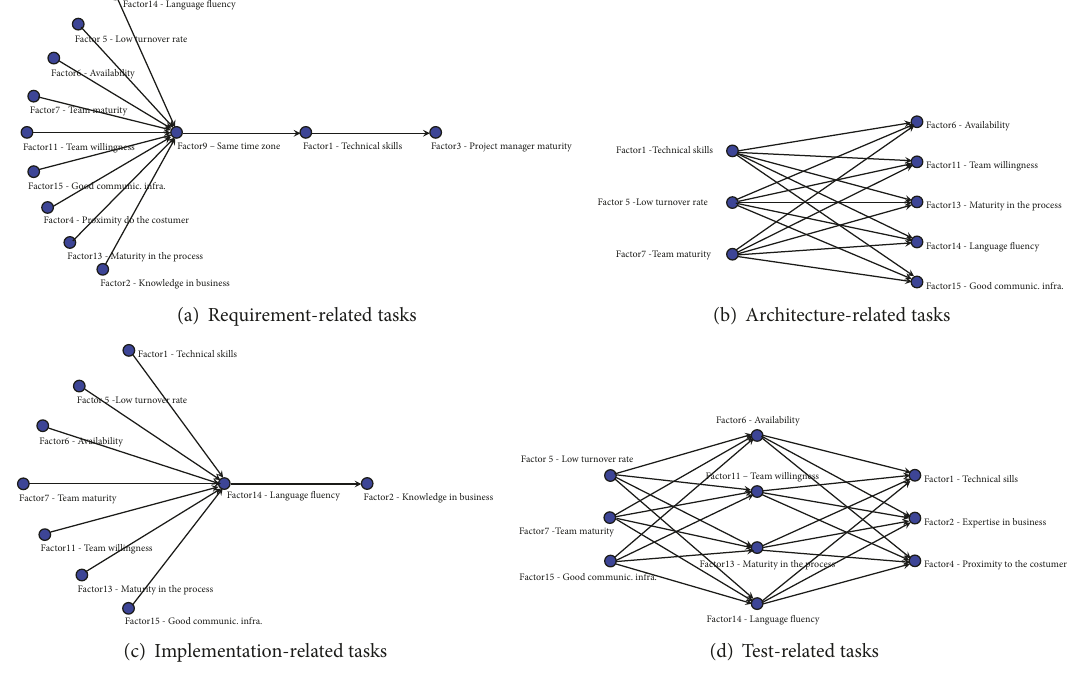
Figure 3: Dominance relations among the alternatives by tasks